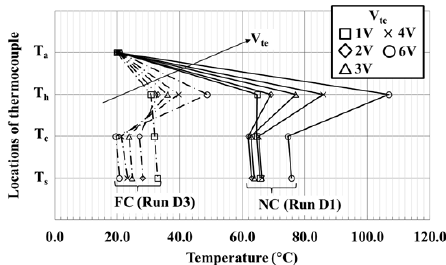
Figure 10. Comparison of interface temperatures for the FHS ‐ TE assembly (NC and FC, P EH = 10 W,